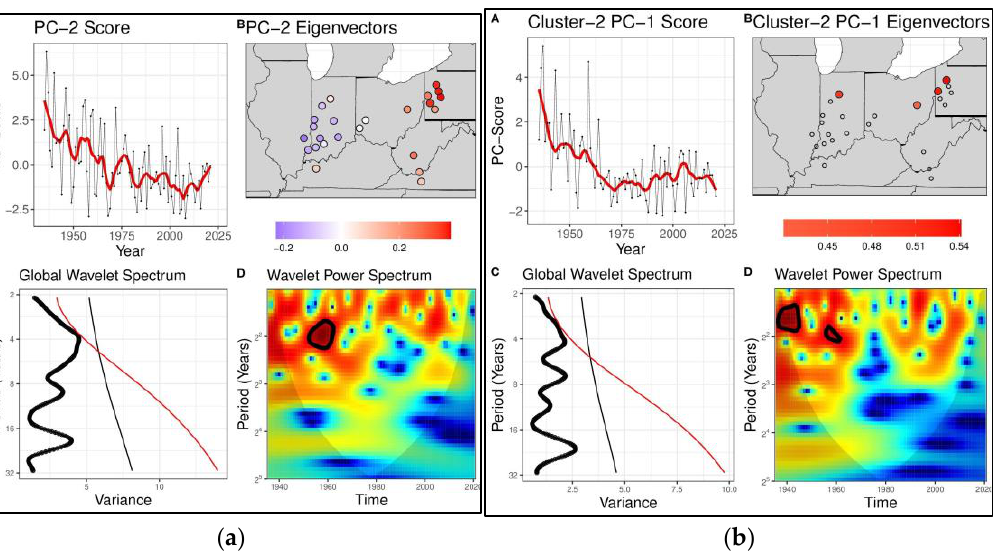
Figure 5. PC-Wavelet analysis (( a )) on the second principal component of the annual maximum streamflow data. Wave-Clust analysis (( b )) on the leading principal component of the second largest cluster of the annual maximum streamflow. For each subplot: ( A )—The principal component score with the local polynomial regression (7-year span) fit in red. ( B )—The eigenvectors of the principal component for the associated stream gauges. The color grey denotes stream-gauges not in the cluster for Wave-Clust. ( C )—Global wavelet spectrum of the principal component score. The red and black lines correspond to the 90% significance level for red and white noise, respectively. ( D )—Wavelet power spectrum of the principal component score. The regions bounded in thick contour line are significant.